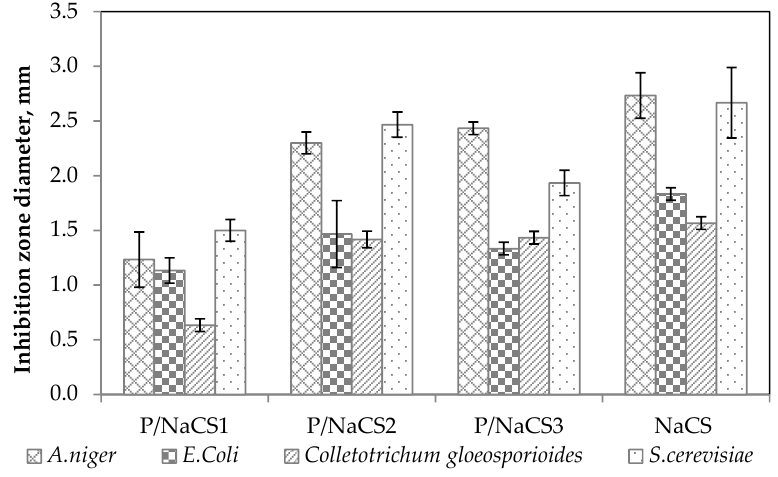
Figure 3. Antimicrobial activities of all films.